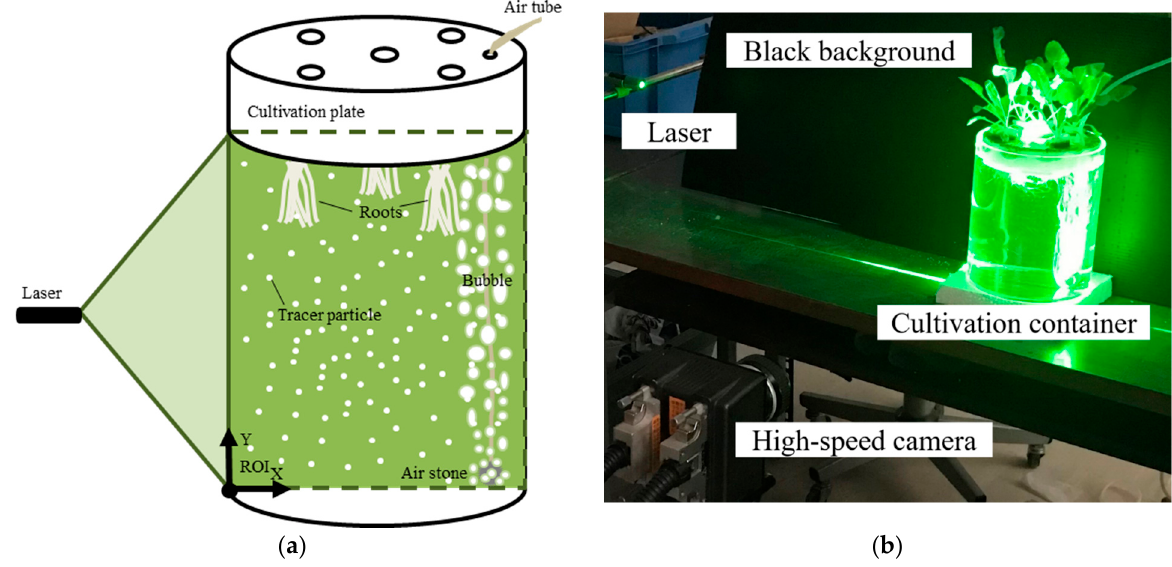
Figure 3. PIV system used in this study. ( a ) Observation method of the bubble flow field and roots in hydroponics. ( b ) The components of the PIV system.